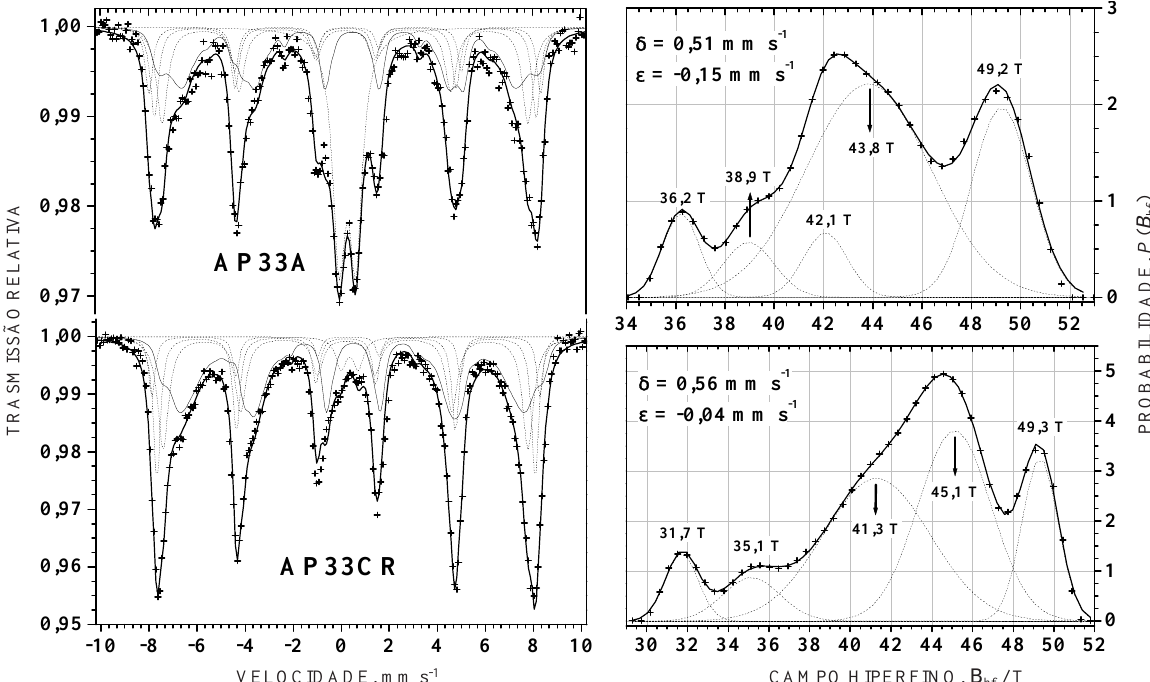
Figura 6. Espectros Mössbauer obtidos na temperatura do ambiente (~298 K) para as amostras de concentrados magnéticos das frações areia do perfil